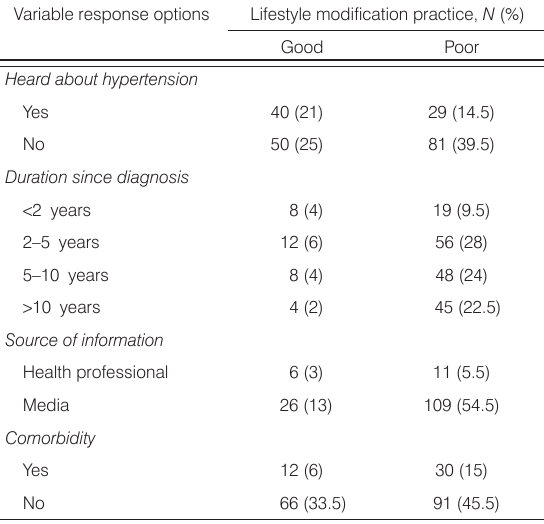
Table 2. Lifestyle modification practices among hypertensive patients.